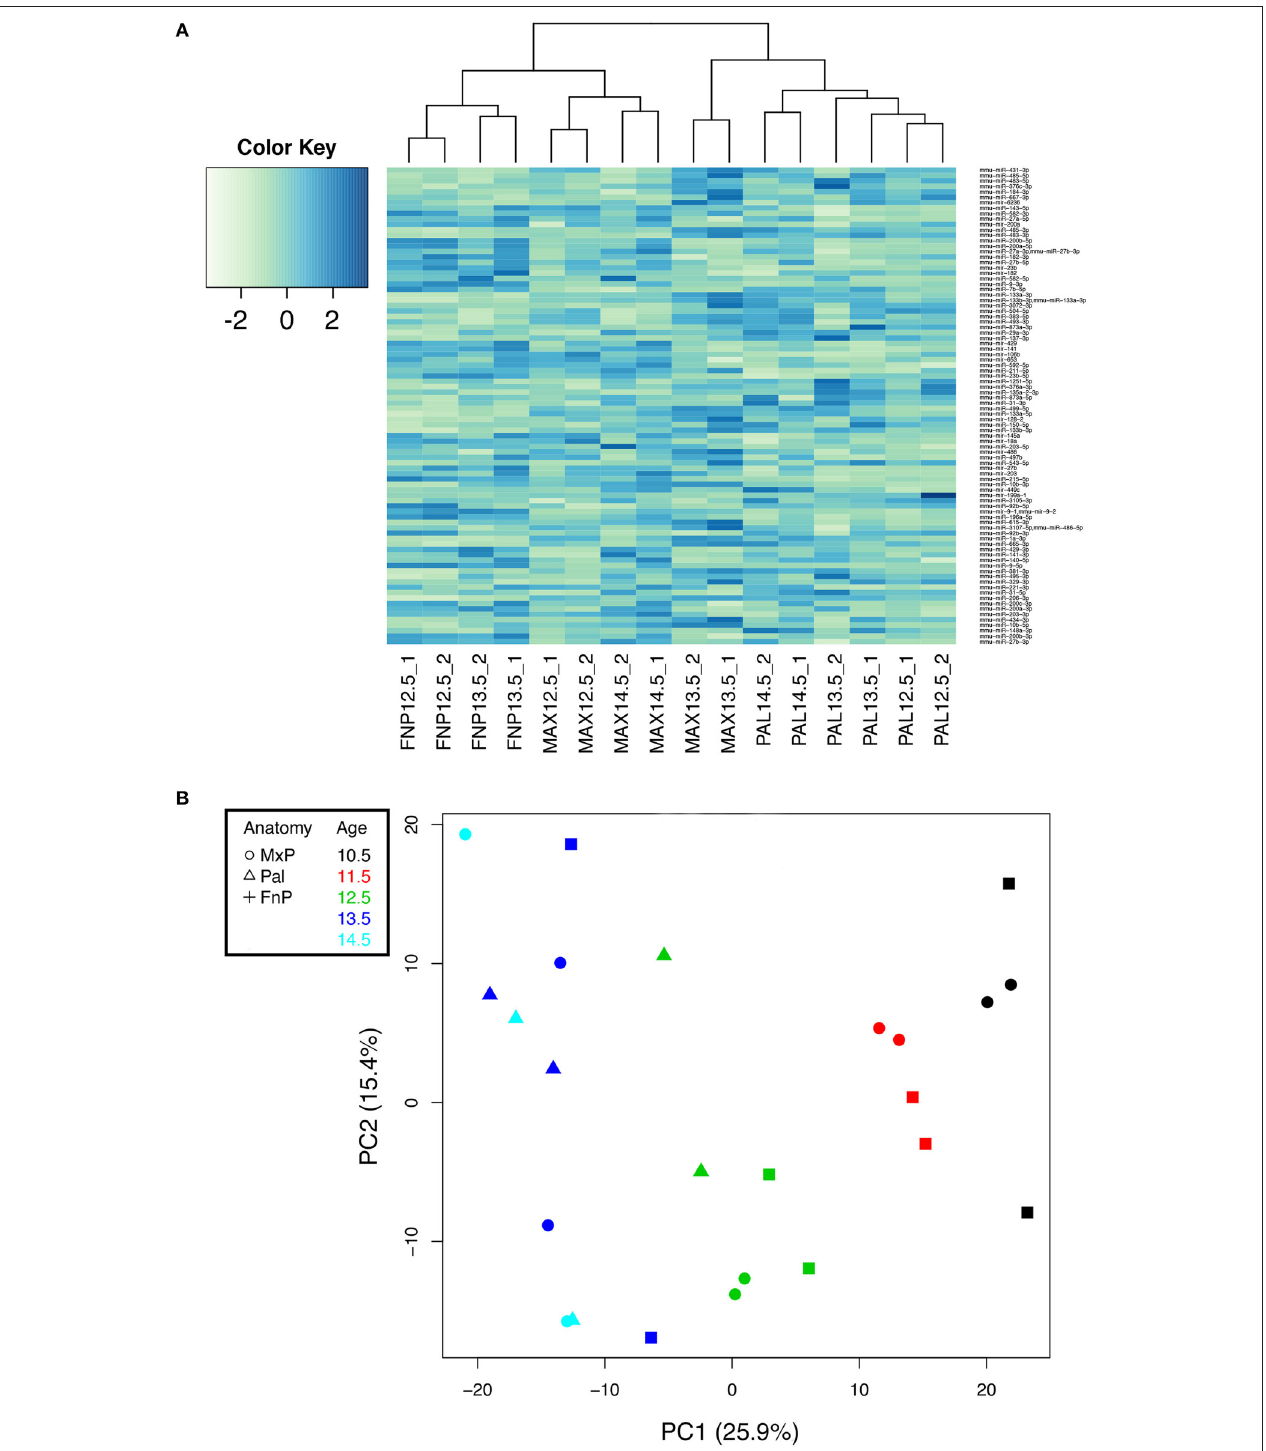
FIGURE 1 | Analysis of miRNA-Seq data defines miRNAs whose expression differs by prominence. (A) 49 mature miRNAs and 11 hairpin miRNAs were differentially expressed by prominence (FDR adjusted p < 0.01 ). Hierarchical clustering of their normalized and scaled expression values (using the R hclust function, ward. D2 method) shows groups of miRNAs enriched in the frontonasal prominence (FnP), palate (Pal), the maxillary prominence (Max), or in combinations thereof. The dendrogram at the top shows the clustering of the samples; the three major divisions correspond to FnP, Pal, and Max, and duplicate samples cluster together. (B) Principal Component Analysis (PCA) analysis of data. Data is color coded by age (inset), with tissue source denoted by symbol (inset). Principal Component 1 (PC1) distributes samples by age. Principal Component 2 (PC2) is orthogonal to PC1 but does not correspond to any obvious property of the samples.